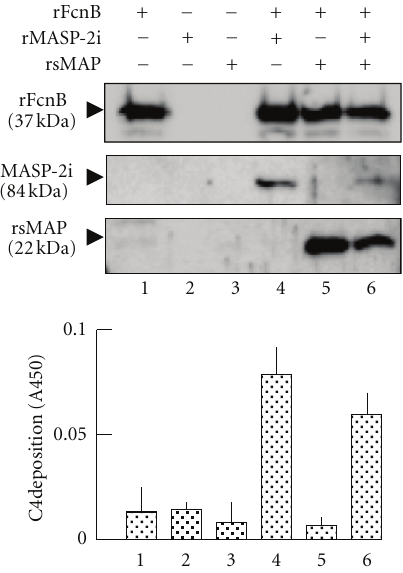
Figure 4: Complement activation by rFcnB/rMASP-2/rsMAP com- plexes. Upper panel: western blot of FcnB and MASP-2/sMAP. After incubation of the recombinant proteins as shown in the table, the generated complexes were pulled down by GlcNAc-agarose and subjected to western blotting. Lower panel: C4-deposition activity of the similar pull-down samples on GlcNAc-BSA-coated microplates. The samples used for C4 deposition were prepared the same as those for western blotting except for employment of rMASP-2a instead of rMASP-2i. The activity was determined in quadruplicate (mean ±